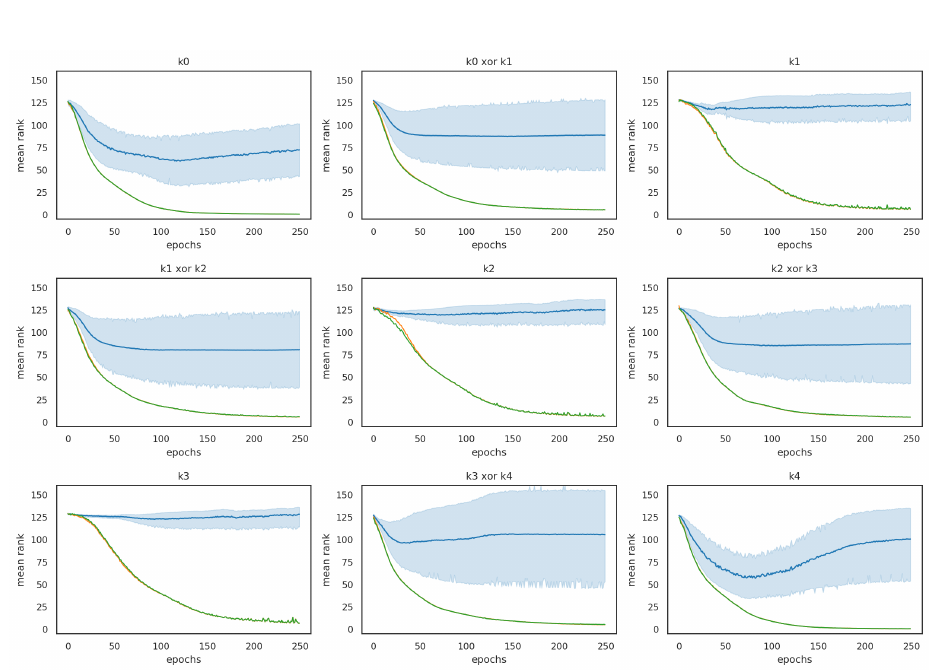
Figure 7: Average validation (orange) and attack rank (green) versus the number of epochs for each of the labels, the two lines mostly overlap. Using the model trained on a single device to attack any of the other five devices we obtain the average rank depicted in blue (with error